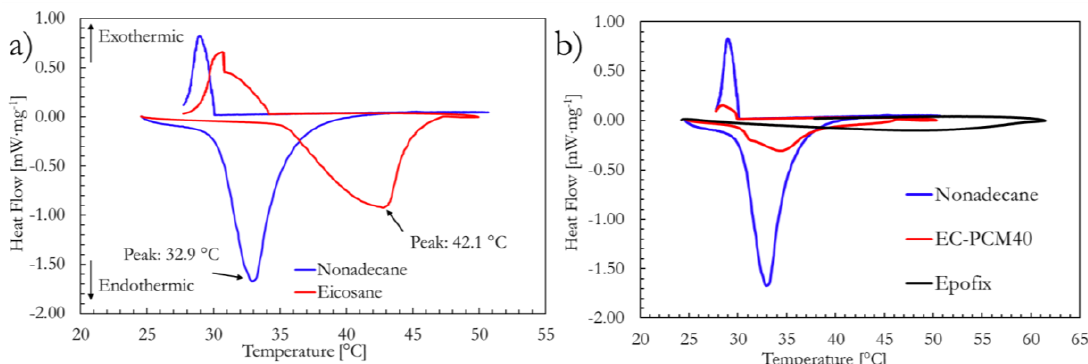
Figure 2 . Differential scanning calorimetry (DSC) curves of the a ) two phase change materials (PCMs) (n-nonadecane and n-eicosane) and b ) PCM, epoxy, and the EC-PCM40 formulation.